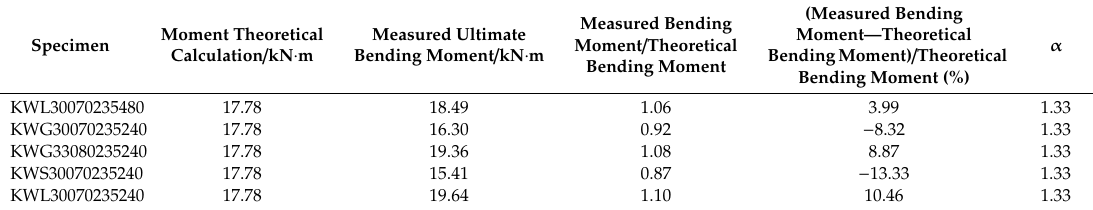
Table 6. Correction of bending